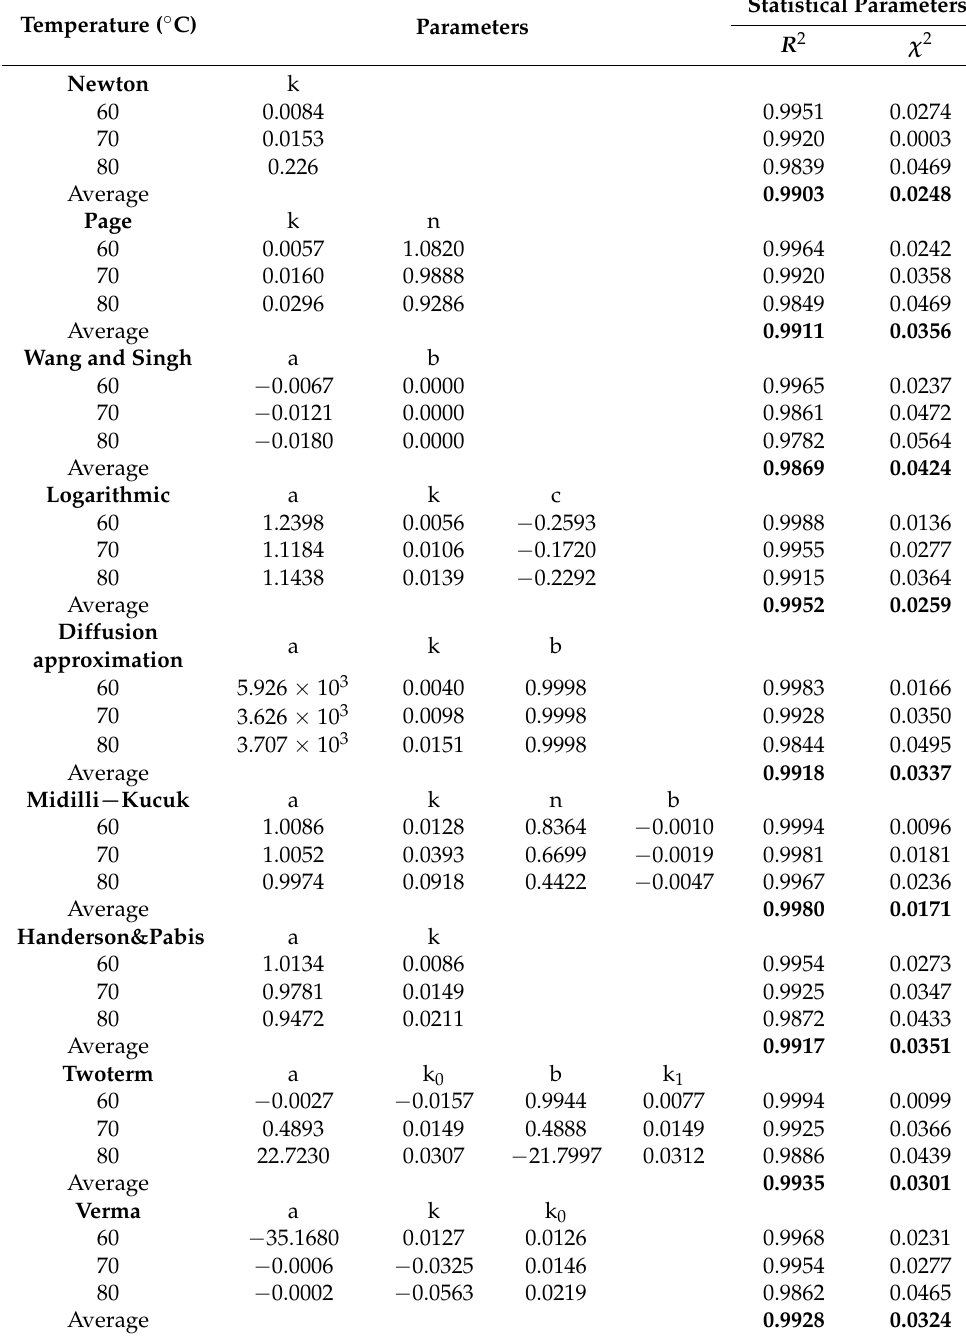
Table 2. List of statistical results generated from all nine